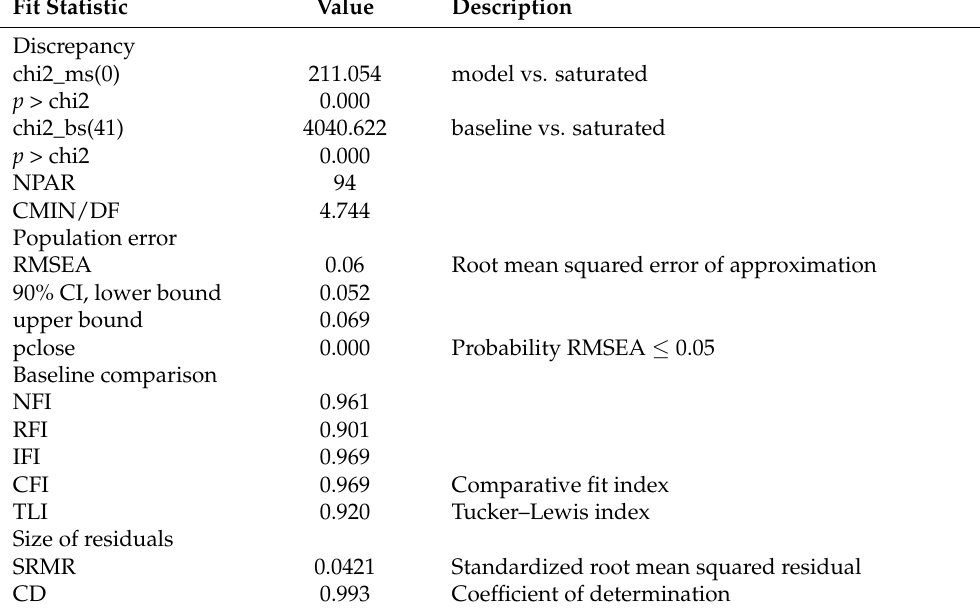
Table 10. A variety of fit indices and goodness-of-fit measures to assess the overall fit of the